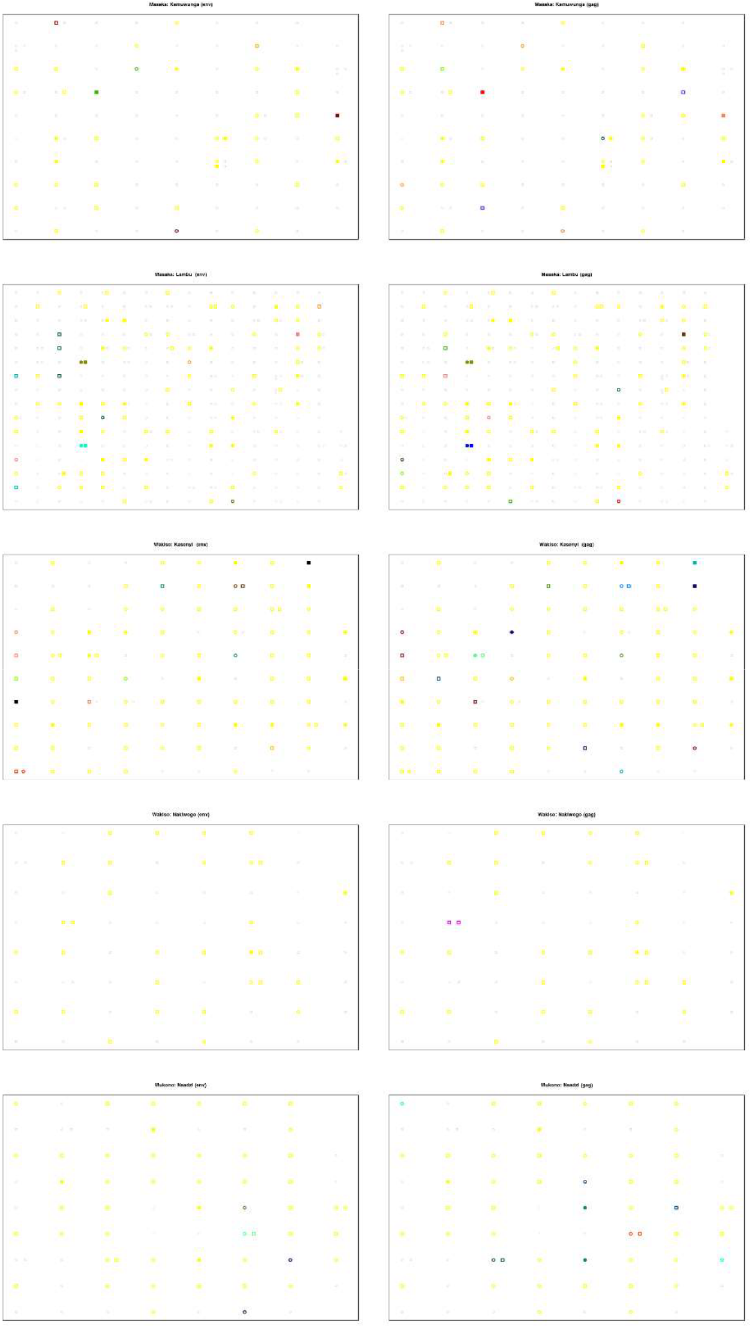
Fig 5. Discretelocation of individuals with identified HIV clusters and gender. In all figures, the gender is indicatedby shape: square = female, circle = male. Non-sequenced is indicatedby grey colour, and sequencedof the non-clusteredindividuals is indicatedby yellow. Cluster memberships are indicatedby coloursother than grey and yellow: the individualshere share the same colour if and only if they belongto the same cluster. Filled circles/squares are incident cases, whilenon-filledones are prevalent cases. In the figure, the locationof each householdis randomly allocatedwithin the correspondingvillage(Masaka district (Lambu, Kamuwungu), Mukono district (Nsadzi), Wakiso district (Kasenyi, Nakiwogo). Household membership, genderand prevalentor incidentHIV status of the HIV infected individualsare presented by villageand by gene